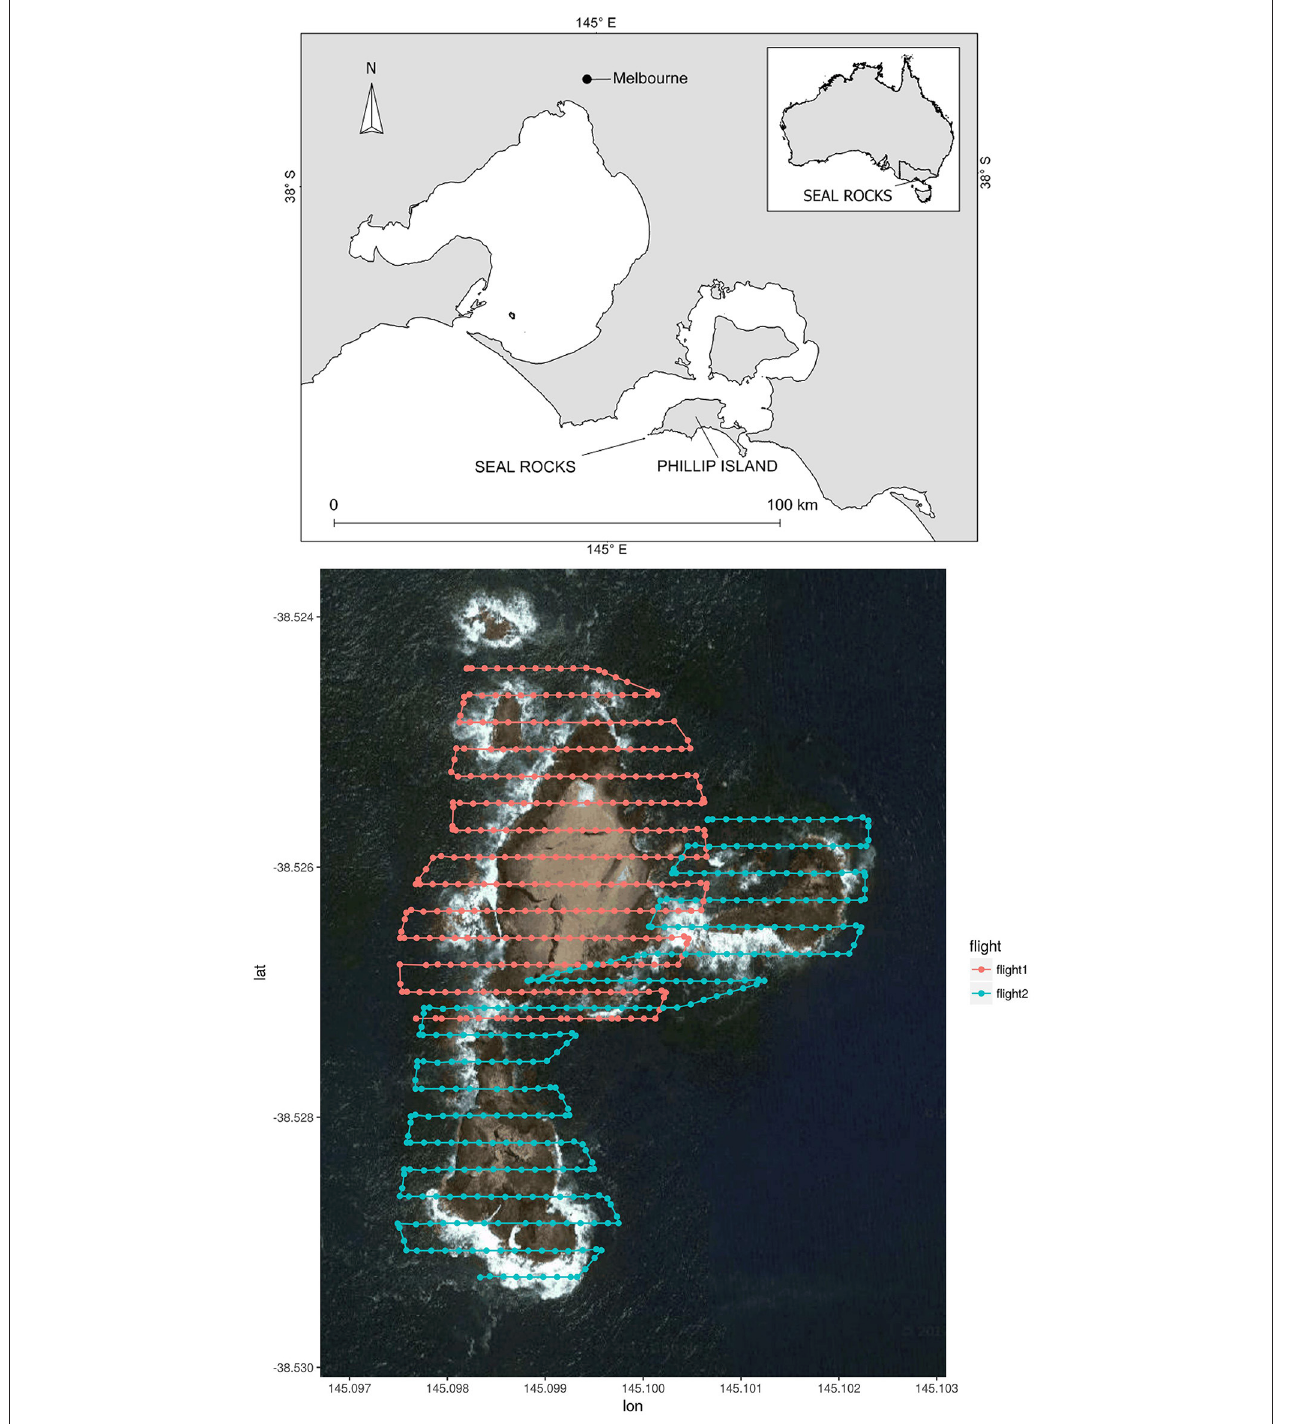
FIGURE 1 | Location of Seal Rocks in Victoria, Australia, and satellite image of Seal Rocks with flight transect lines (for DJI Phantom 4 Pro at 40m ASL) overlayed. Flight 1 covered Seal Rock and flight 2 covered East Reef and Black Rock. The points on the transect lines identify the locations where photographs were taken, once every 2s ( > 300 images/flight). Ground speed during capture is maintained at ∼ 7 m/s. Seal Rocks covers approximately eight hectares in area.